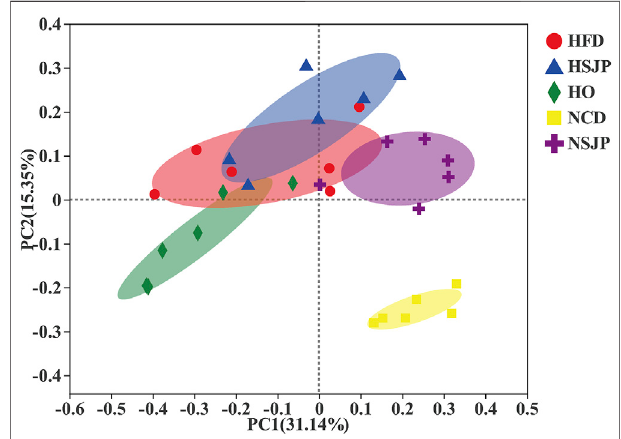
FIGURE 6 | Microbiota response to dietary supplementation with SJP in C57BL/6 mice. Principal coordinate analysis plot of microbiota in